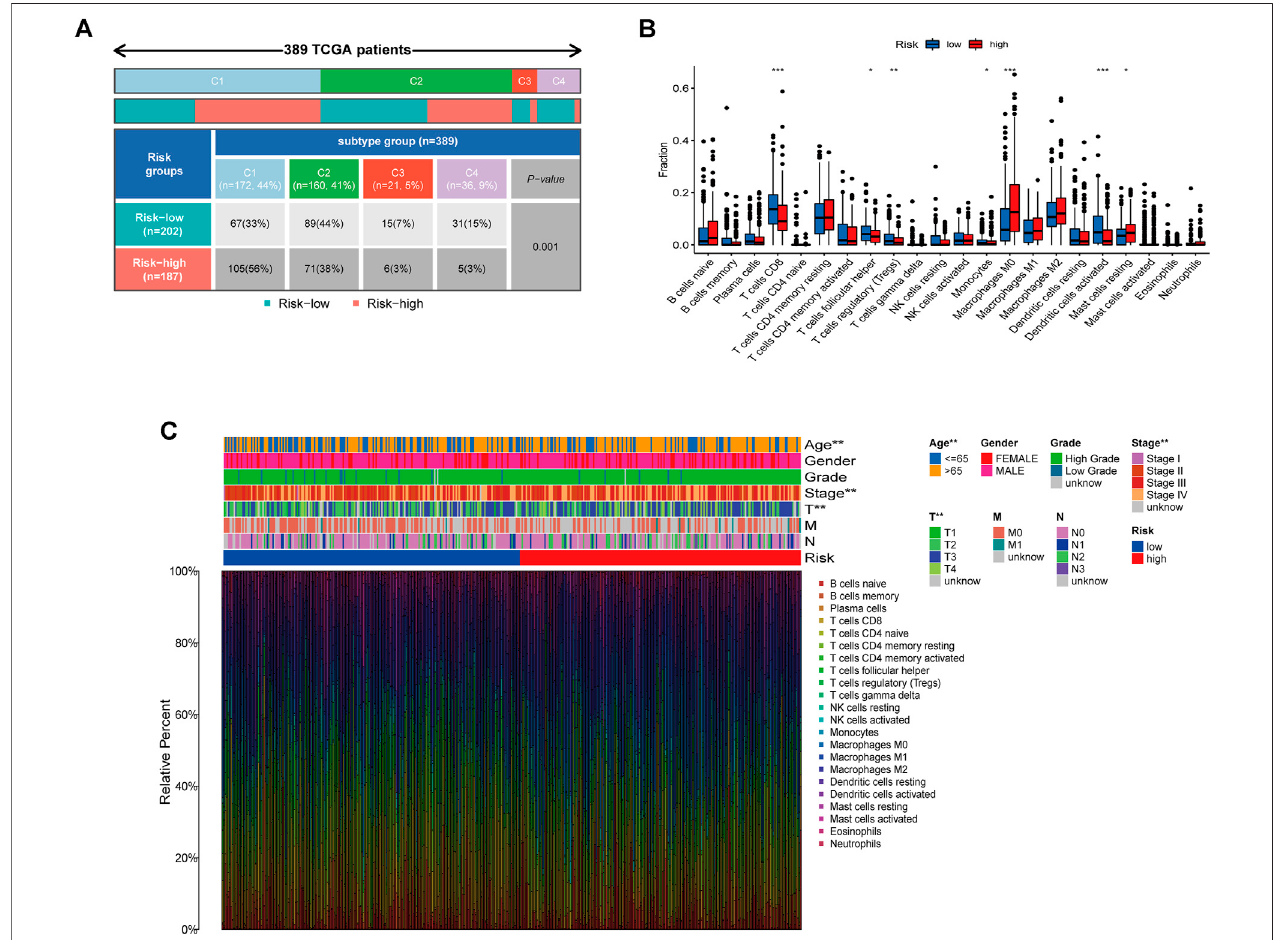
FIGURE 7 | Correlation between the risk model and immunity. (A) Different immune subtypes distributed in the two risk groups. (B) Two risk subgroups with different proportions of immune cells. (C) Clinical features of risk with the immune landscape. * p < 0.05, ** p < 0.01,*** p < 0.001.